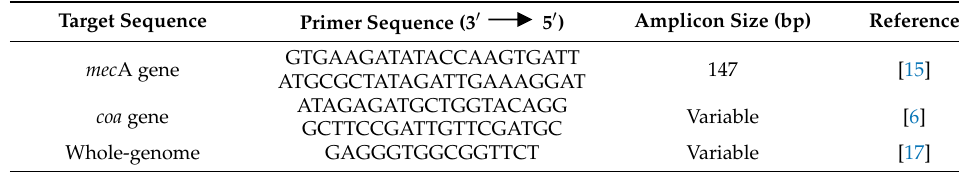
Table 1. Nucleotide sequences of the primers used in this study.